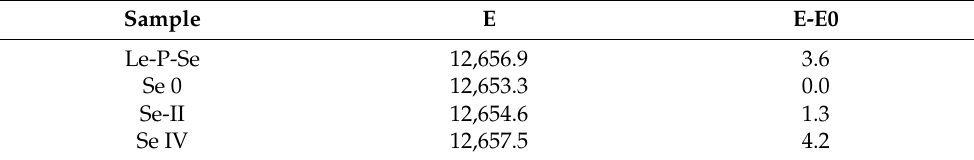
Table 2. Edge energy values for the experimental samples and reference samples.